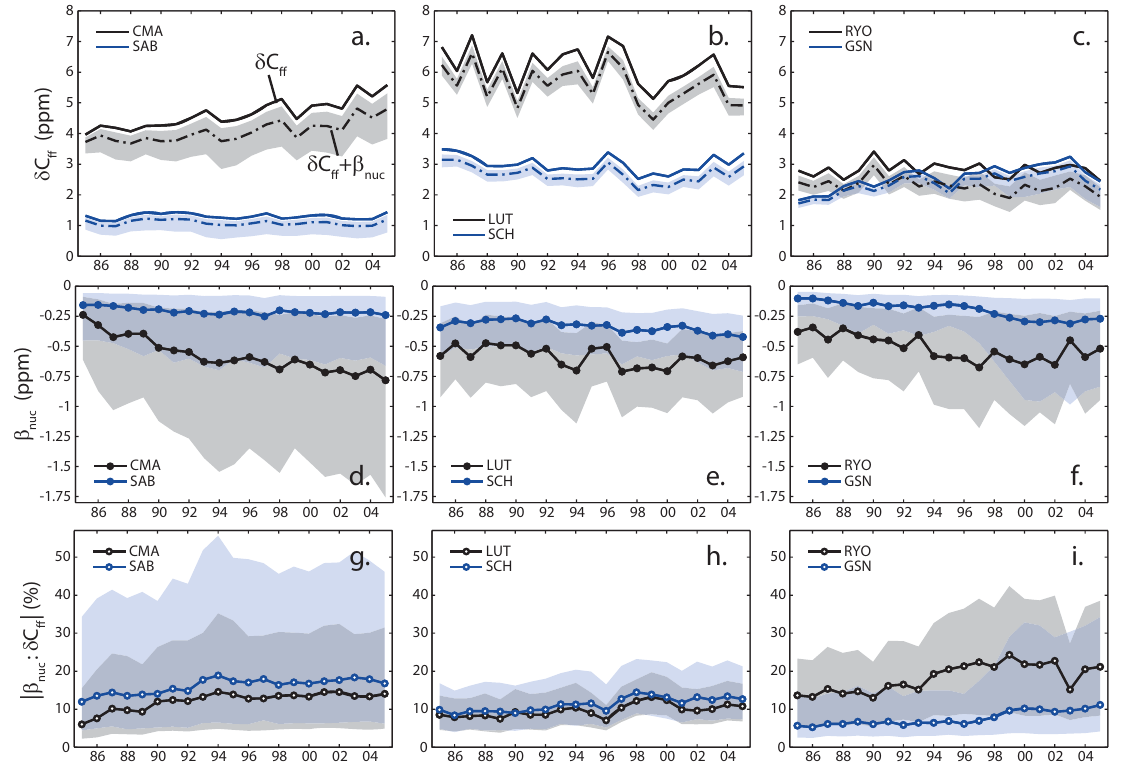
Fig. 4. (a–c) Annual mean fossil fuel-derived CO 2 ( δC ff , solid lines) and fossil fuel-derived CO 2 including the nuclear bias ( δC ff + β nuc , dashed lines) simulated at each observation site for 1985–2005. (d–f) Annual mean β nuc simulated at each observation site for 1985–2005. Panels (g–i) Annual mean ratio | β nuc : δC ff | simulated at each observation site for 1985–2005, in percent. Filled areas show 70% confidence